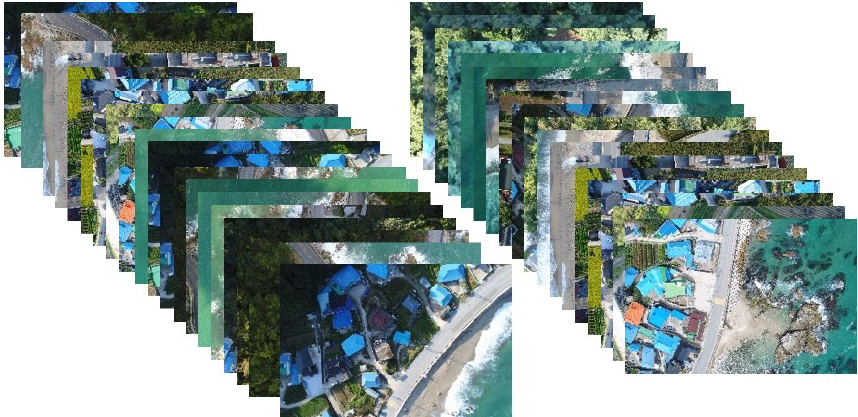
Figure 2. Images collected during the flight of the UAV equipped with a high-resolution camera.